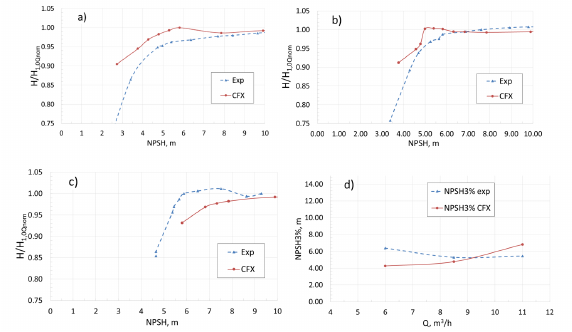
Figure 11: The comparison of the cavitation performance curves obtained by means of the experimental and numerical tests for dif- ferent flow rates: a) 0.7 Q nom ; b) 1.0 Q nom ; c) 1.3 Q nom ; and external characteristic: d) NPSH3% curves